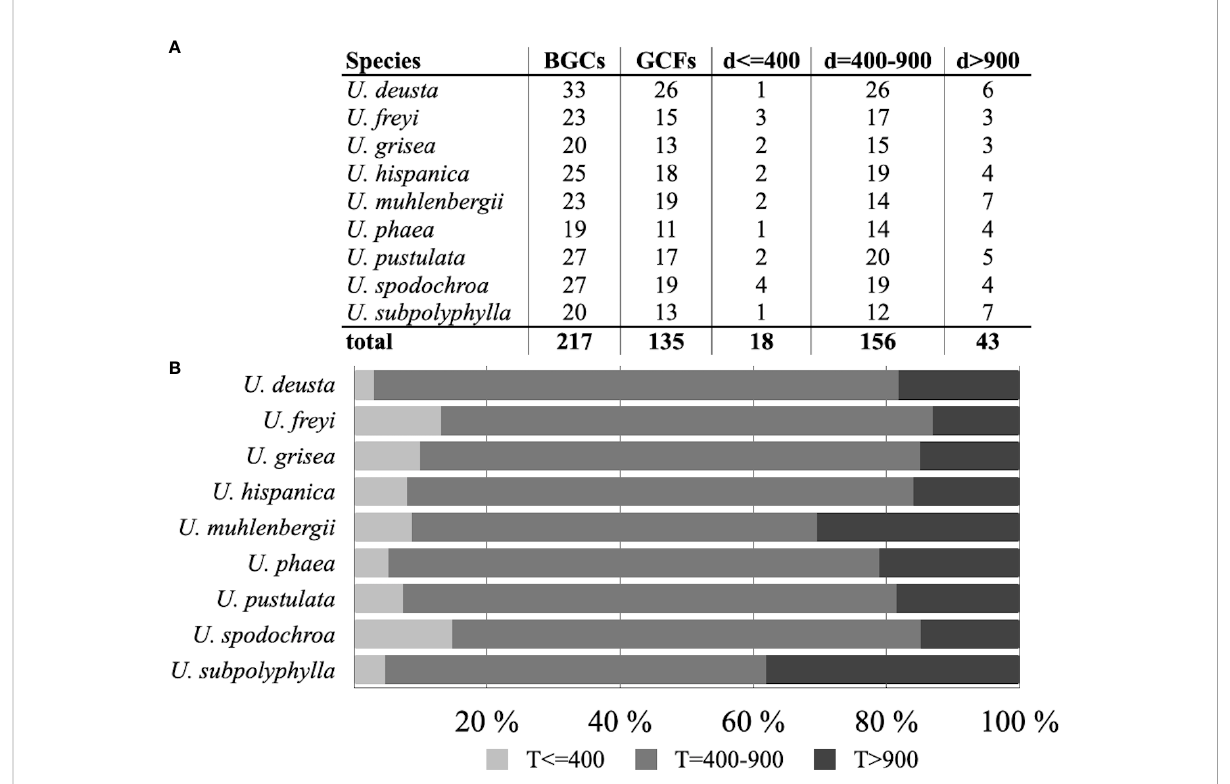
FIGURE 3 (A) Total biosynthetic gene clusters (BGCs) and gene cluster families (GCFs) as identi fi ed by BiG-FAM in Umbilicaria, along with the number of BGCs clustering into pre-characterized GCFs in BiG-FAM and their distance (d) groups. Distance is a measure of how closely a given BGC is related to other BGCs ( d ≤ 400 suggests that the cluster codes for a structurally and functionally similar NP; d = 400 – 900 indicates that the BGC codes for a related but structurally and functionally divergent NP; and d > 900 suggests that the BGC potentially codes for a novel NP). (B) Bar plots representing the percentage of BGCs in each Umbilicaria species with d ≤ 400, d = 400 – 900, and d > 900. Only a small proportion of BGCs in each species could be grouped into a pre-characterized GCF in the BiG-FAM database (21,678 species, 1,225,071 BGCs, and 29,955 GCFs), whereas a large proportion of BGCs are only distantly related to the pre-characterized BGCs. Approximately 15% – 30% of BGCs could not be grouped into BiG-FAM GCFs and, therefore, potentially code for structurally and functionally divergent